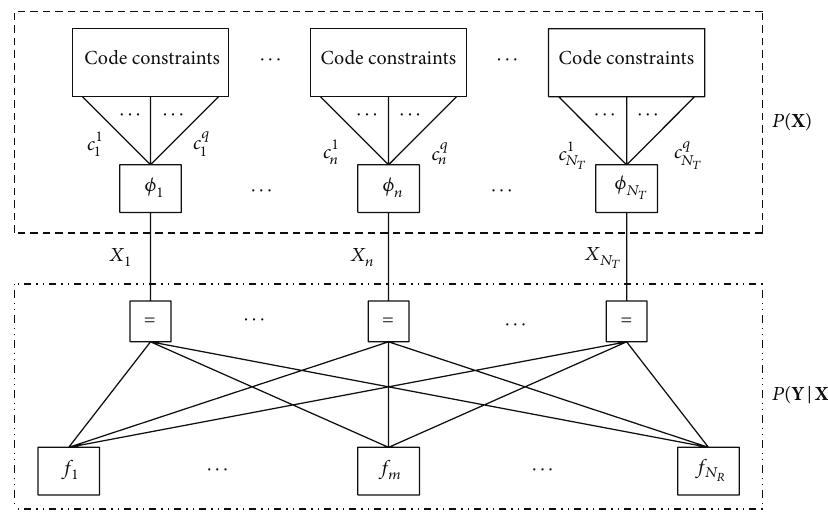
Figure 3: Factor graph model of multiuser MIMO communication system at one